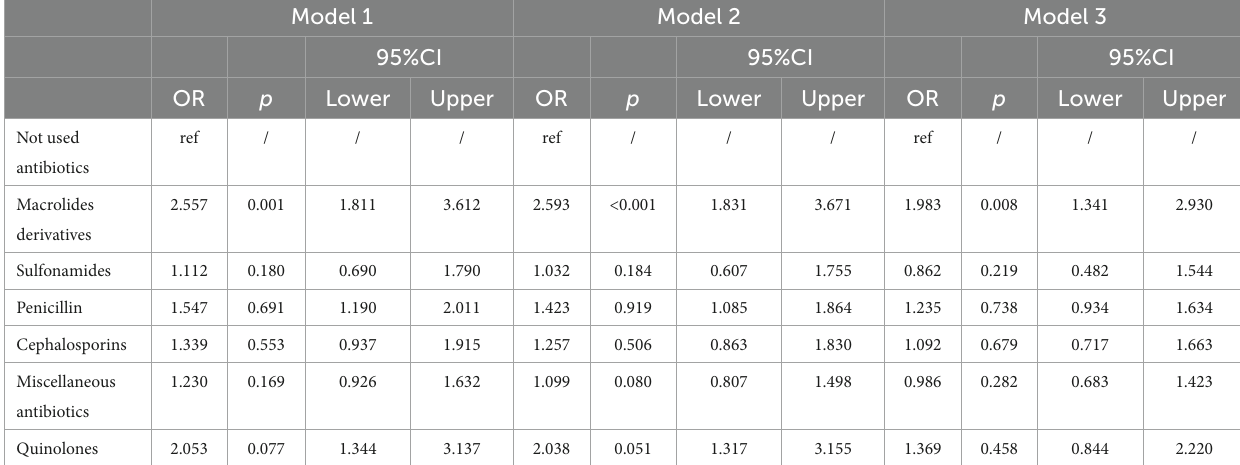
TABLE 2 Association of asthma and antibiotics use among American adults: NHANES